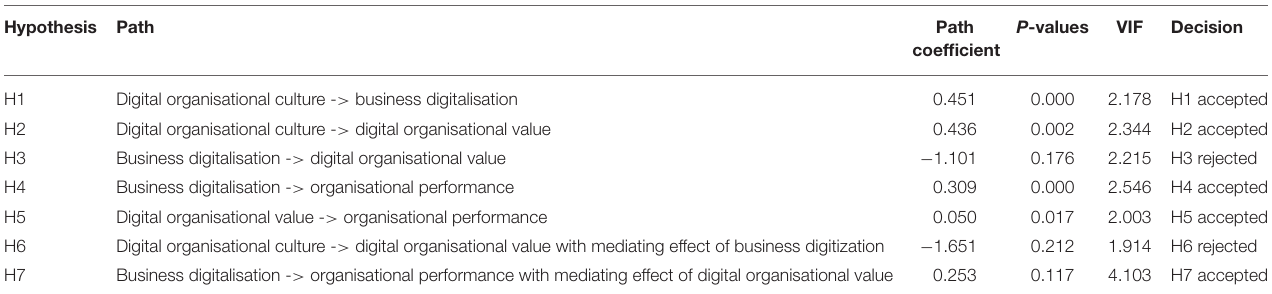
TABLE 5 | Summary of statistical test